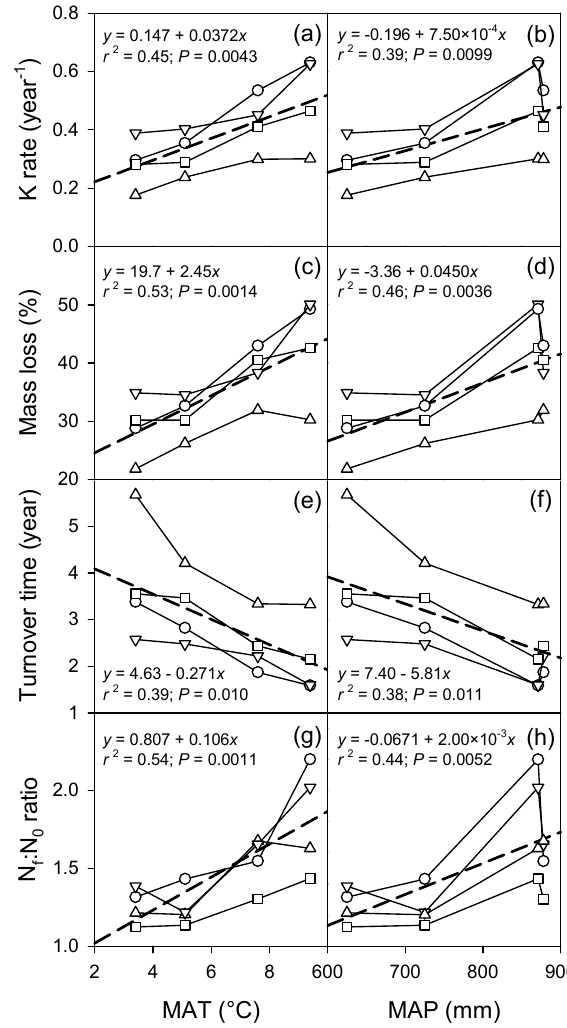
Figure 3. Litter decomposition traits of four different tree litter species with different origin decomposed in four European sites with different mean annual temperature ( T a ) and mean annual pre- cipitation ( P ). Symbols as in Fig. 1. Data corresponding to the same origin of litter are connected with a solid line to visually evaluate the evolution of the trait across the T a and P range. The dashed line represents the Pearson’s linear regression best fit of all the data. Traits are first-year decomposition k rate (a, b) , percentage of mass loss after 1year of decomposition relative to initial mass (c, d) , es- timated litter turnover time (e, f) , and ratio between final litter N content (N f ) after 1year of decomposition and the initial nitrogen content (N 0 )